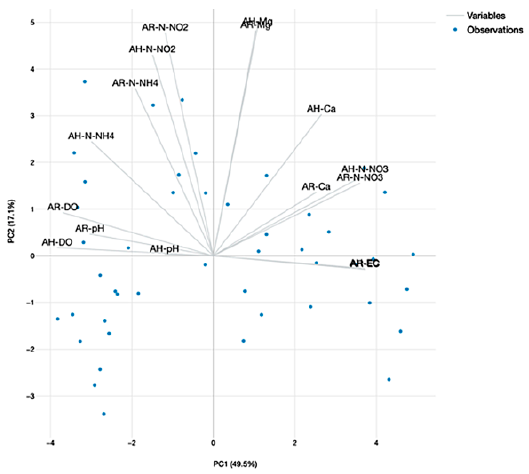
Figure 28. The PCA for water quality parameters associated to A dataset.